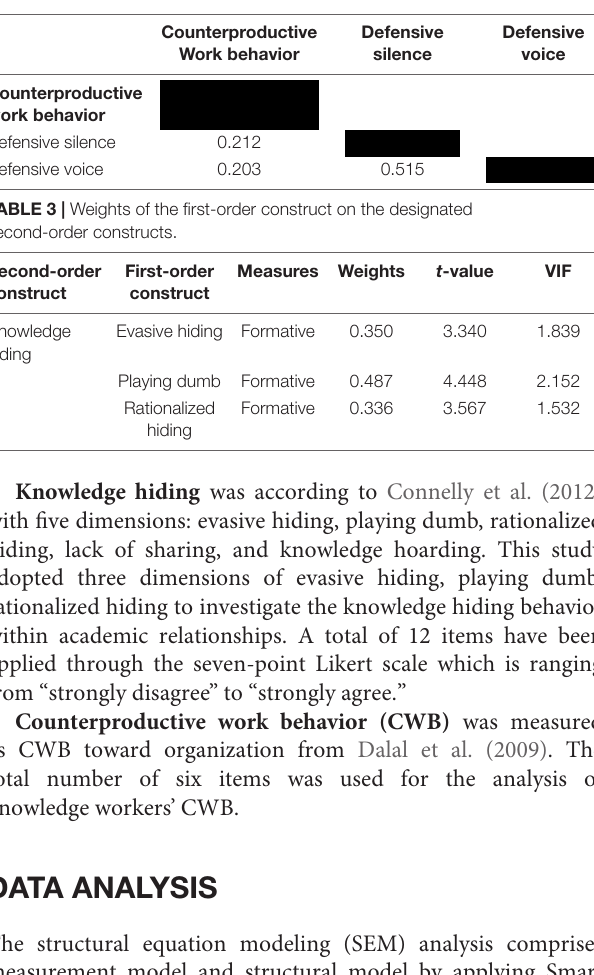
TABLE 2 | Discriminant validity-heterotrait-monotrait ratio of correlations (HTMT).